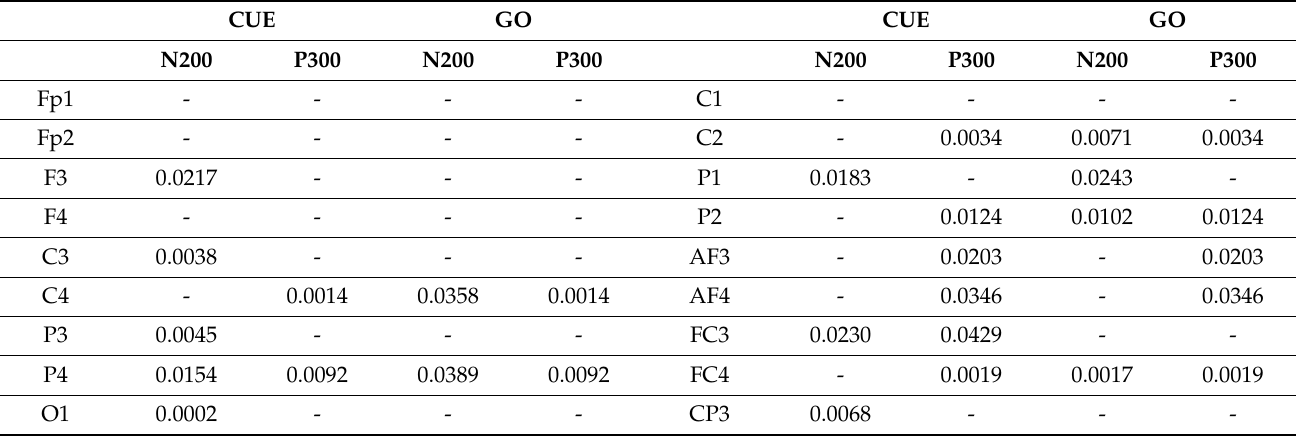
Figure 3. Mean scalp distribution of potentials in directional stimuli (DS) and non-directional stimuli conditions, and maps of statistical differences ( p -value distribution) between DS and nDS in the cue ( A ) and go ( B ) stimulus for N200 and P300 latencies. Table 1. Significant values ( p < 0.05) related to all electrodes for N200 and P300 in the cue stimulus and the go stimulus between DS and nDS conditions. “-” indicates non-significant results. The results were corrected using the FDR method to resolve the issue of multiple comparisons.